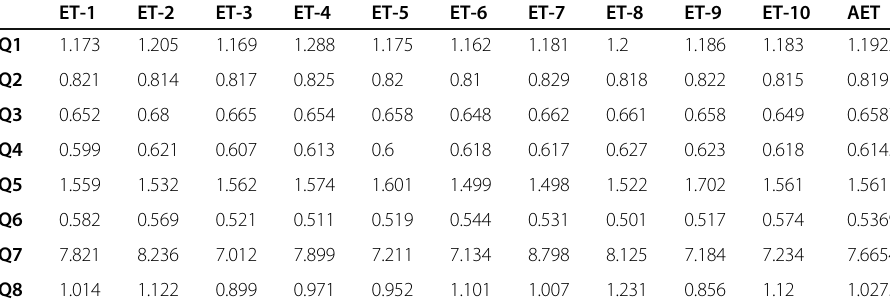
Table 5 Query execution time for Amazon EC2 with Washington State data in